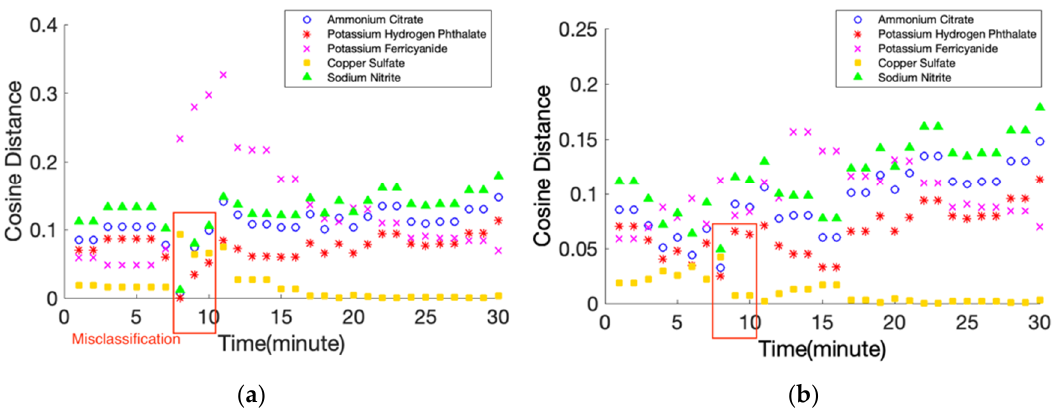
Figure 9. Classification results of 5 mg/L Copper Sulfate solution before and after the fusion of cross-correlation information. ( a ) Before the introduction of cross-correlation information; ( b ) after the introduction of cross-correlation information.